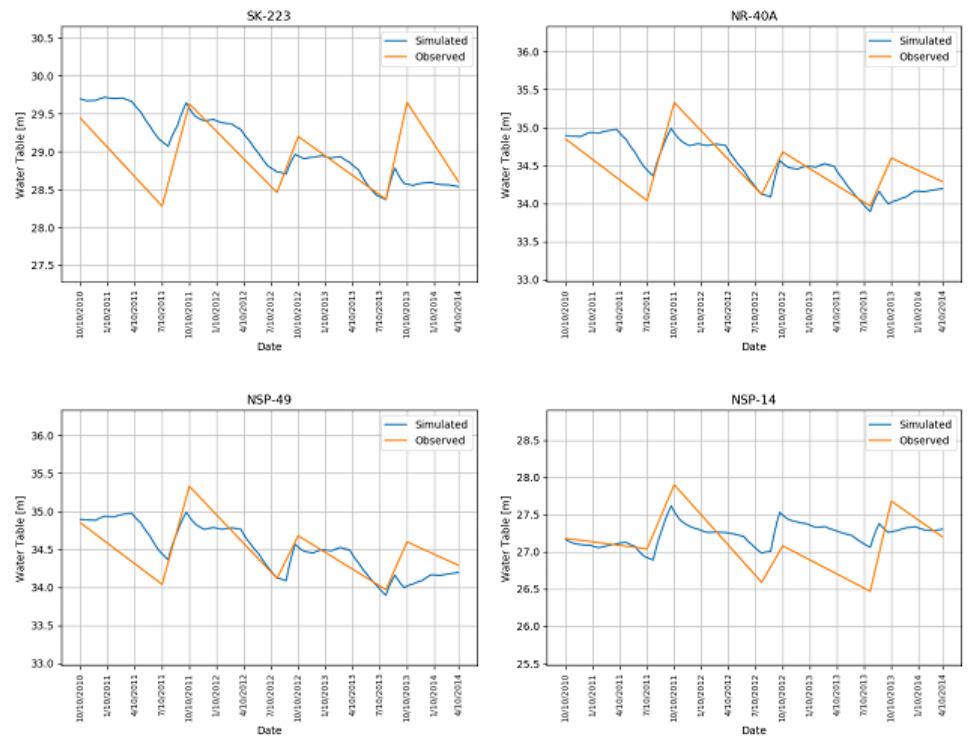
Figure 9. Hydrographs of simulated and observed water levels in meters for the model calibration period (i.e., October 2010–April 2014).